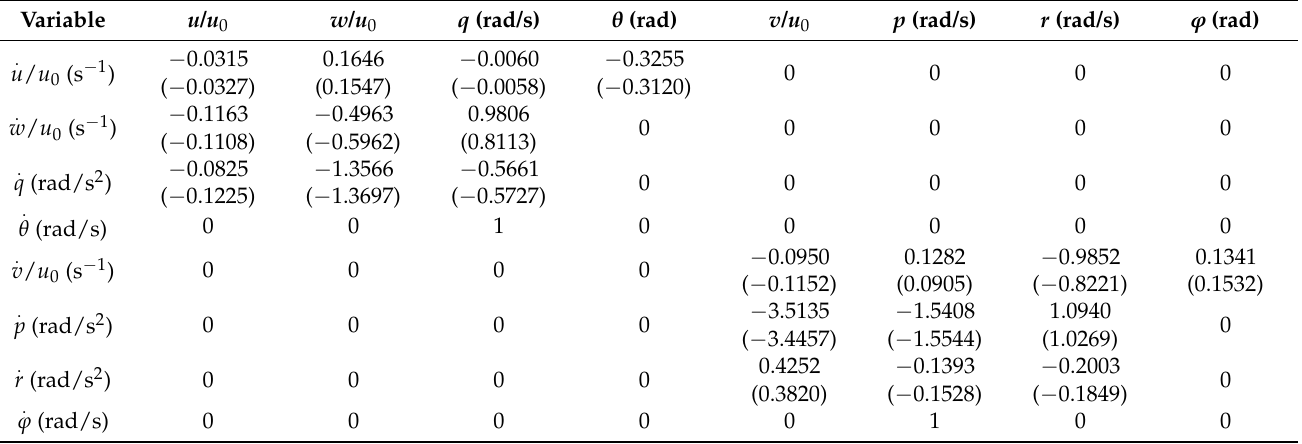
Table 25. CFD–RANS (extrapolated) 8 × 8 stability matrix for flight condition 19 in Tables 4 and 22 (reference takeoff